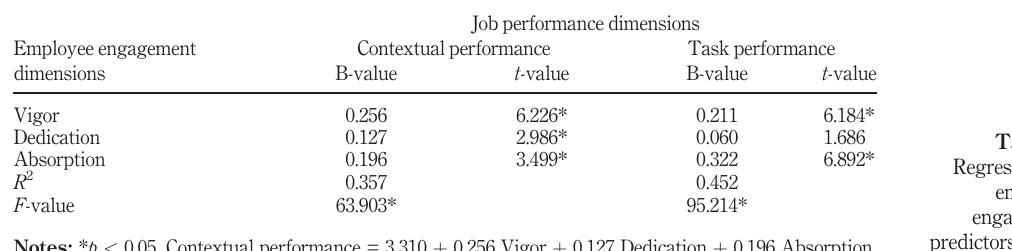
Table 1. Regression